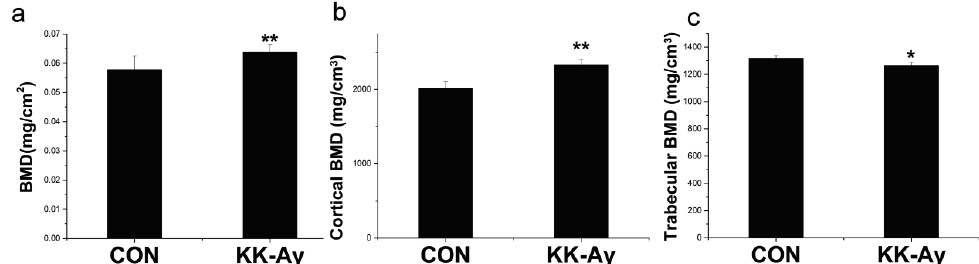
Figure 2. Femoral BMD in control (CON) and KK-Ay mice The areal bone mineral density (aBMD) of the control and KK-Ay mice were measured using dual energy X-ray absorptiometry, and the volumetric BMD (vBMD) was detected using micro-computed tomography measurements. ( a ) BMD of right femur; ( b ) cortical vBMD of right distal femur; ( c ) trabecular vBMD of right distal femur; n = 4–10, * p < 0.05 vs. CON, ** p < 0.01 vs. CON. The data are shown as the means ± SE.